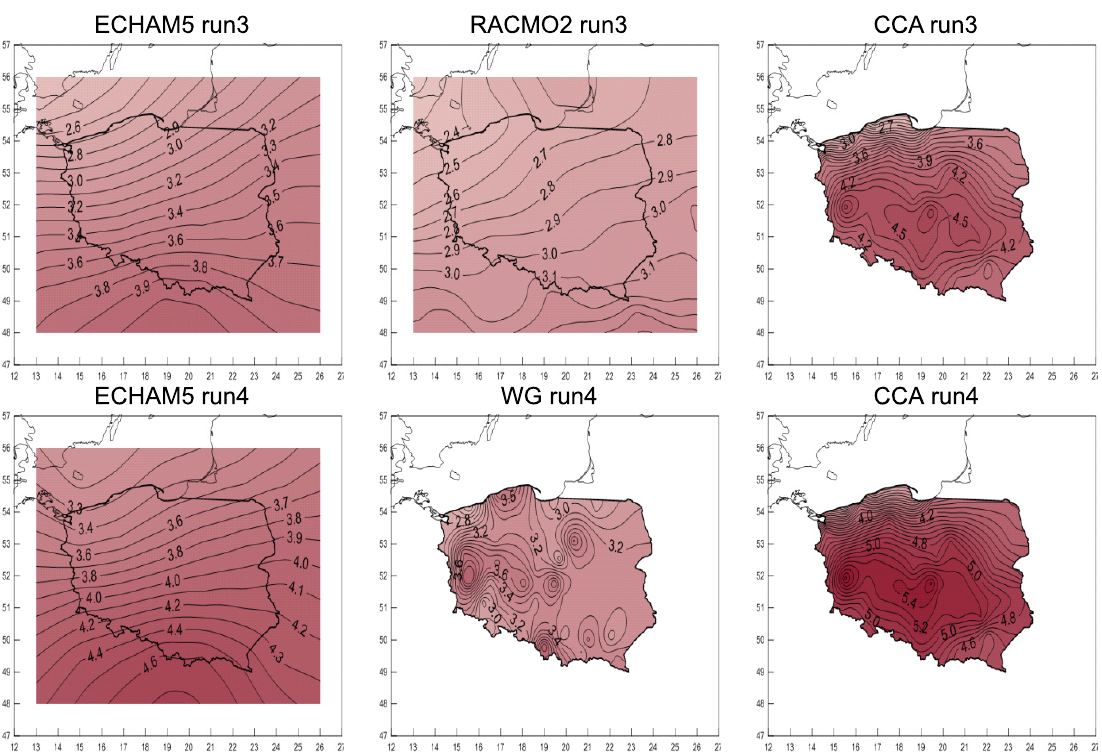
Fig. 11. Anomalies of air temperature (°C) in the summer season (JJA) 2071–2090 in relation to reference period (1971–2000) in Poland based on A1B emission scenario for models: ECHAM5 run 3and 4, RACMO2 run 3, CCA run 3 and 4, WG run 4.